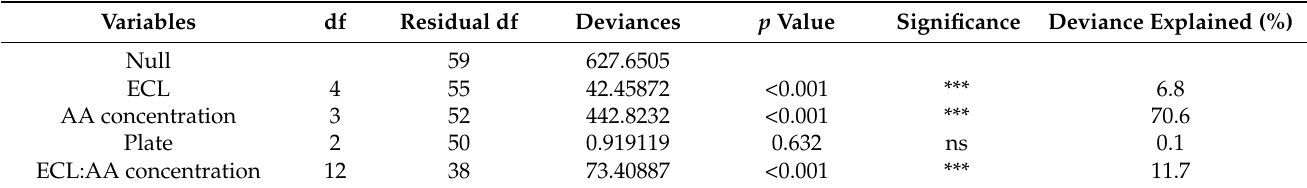
Table 10. Summary of deviances of the generalized linear model (GLM) of data from Table 9 (Effect of amino acid (AA) concentration on somatic embryo maturation efficiency of sugi embryogenic cell lines (ECLs)). Deviance of the variable “null” indicates the null deviance (deviance of the null model), and other deviances indicate the residual deviance (deviance of the